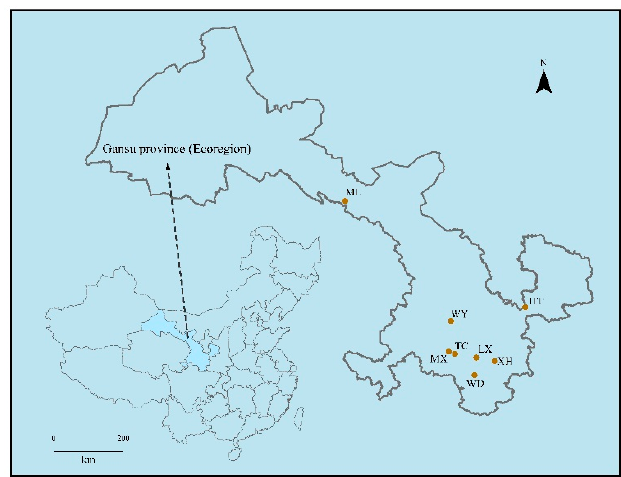
Figure 1. Simplified map of sampling area showing location.